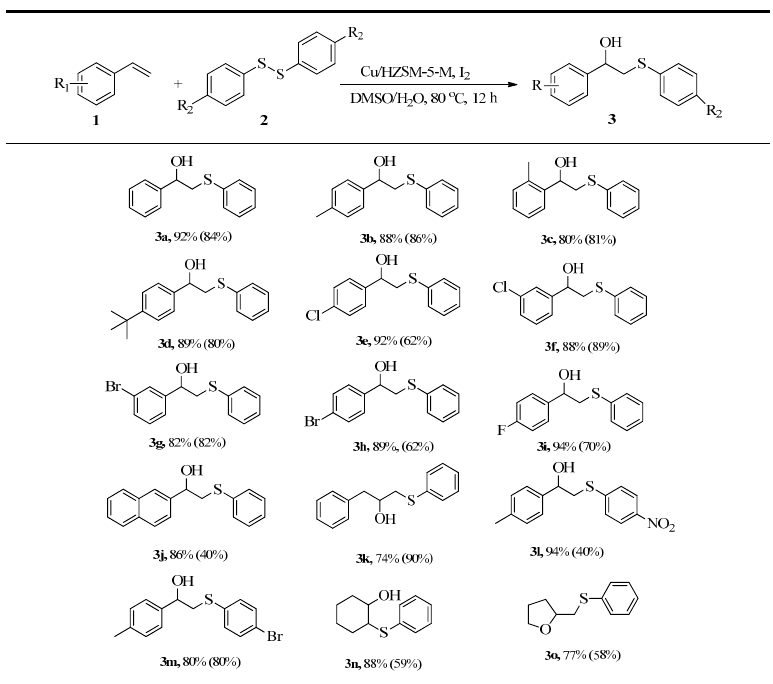
Table 3. Hydroxysulfurization reaction between alkenes and diaryl disulfides 1 .